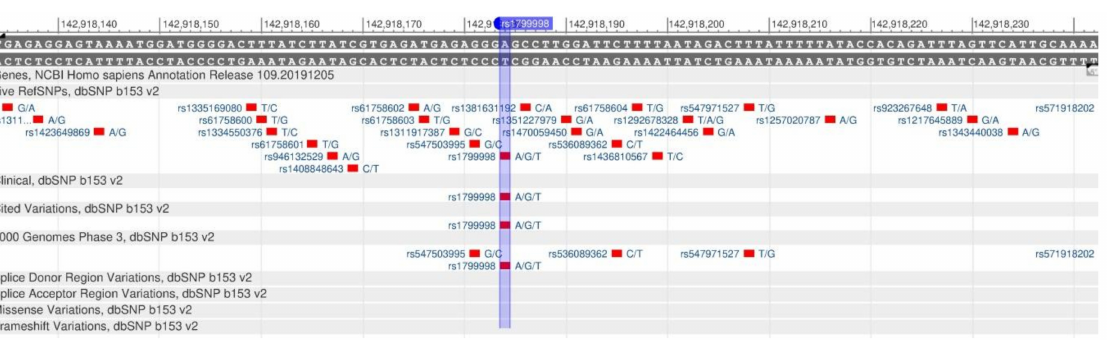
Figure 29. A plot of the CYP11B2 gene (located on the long (q) arm of chromosome 8) containing the oligonucleotide polymorphism